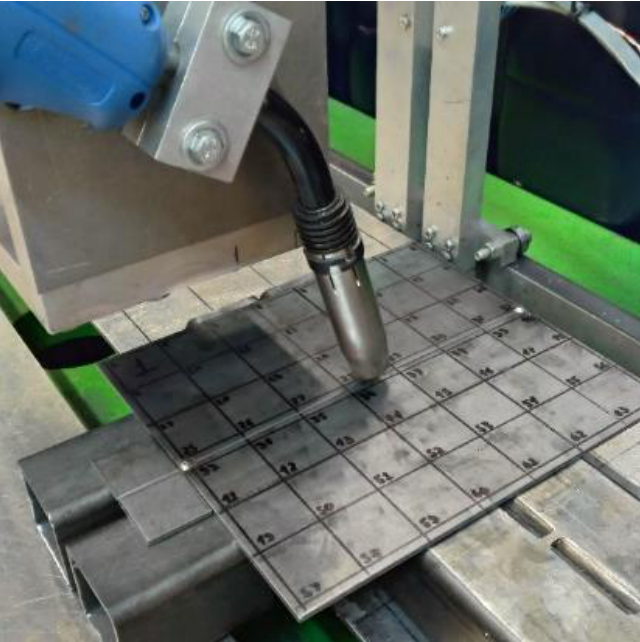
Figure 8. Arrangement without movement restrictions during the welding process in top joints.